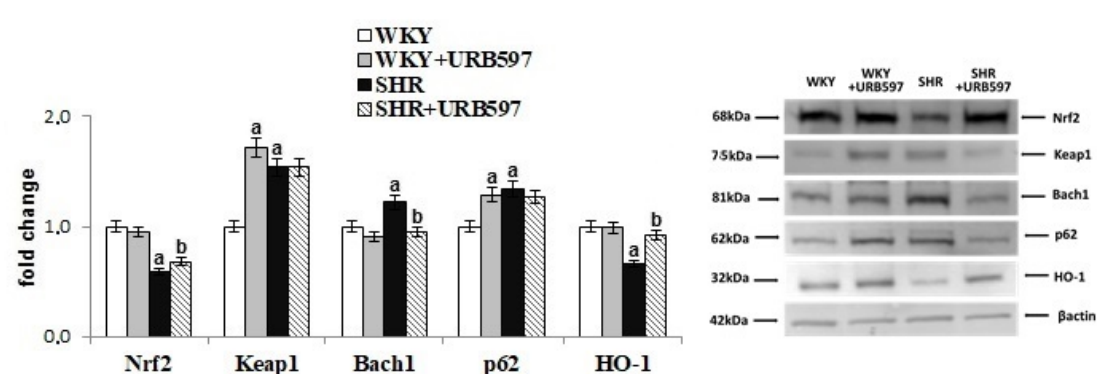
Figure 2. The levels of Nrf2 and its activator (p62) and inhibitors (Keap1, Bach1) as well as HO-1 in the brain of spontaneously hypertensive rats and hypertensive rats after URB597 administration. The expression of the examined proteins is shown compared to the control groups. Data points represent the mean ± SD, n = 6; (a, significantly different from the WKY group, p < 0.05; b, significantly different from the SHR group, p < 0.05).